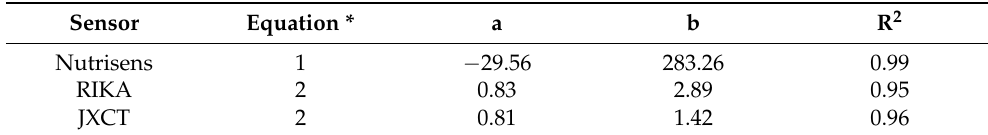
Table 3. Fitting and the determination coefficients for the probes when increasing the nitrate concen- tration in liquid medium. Sensor